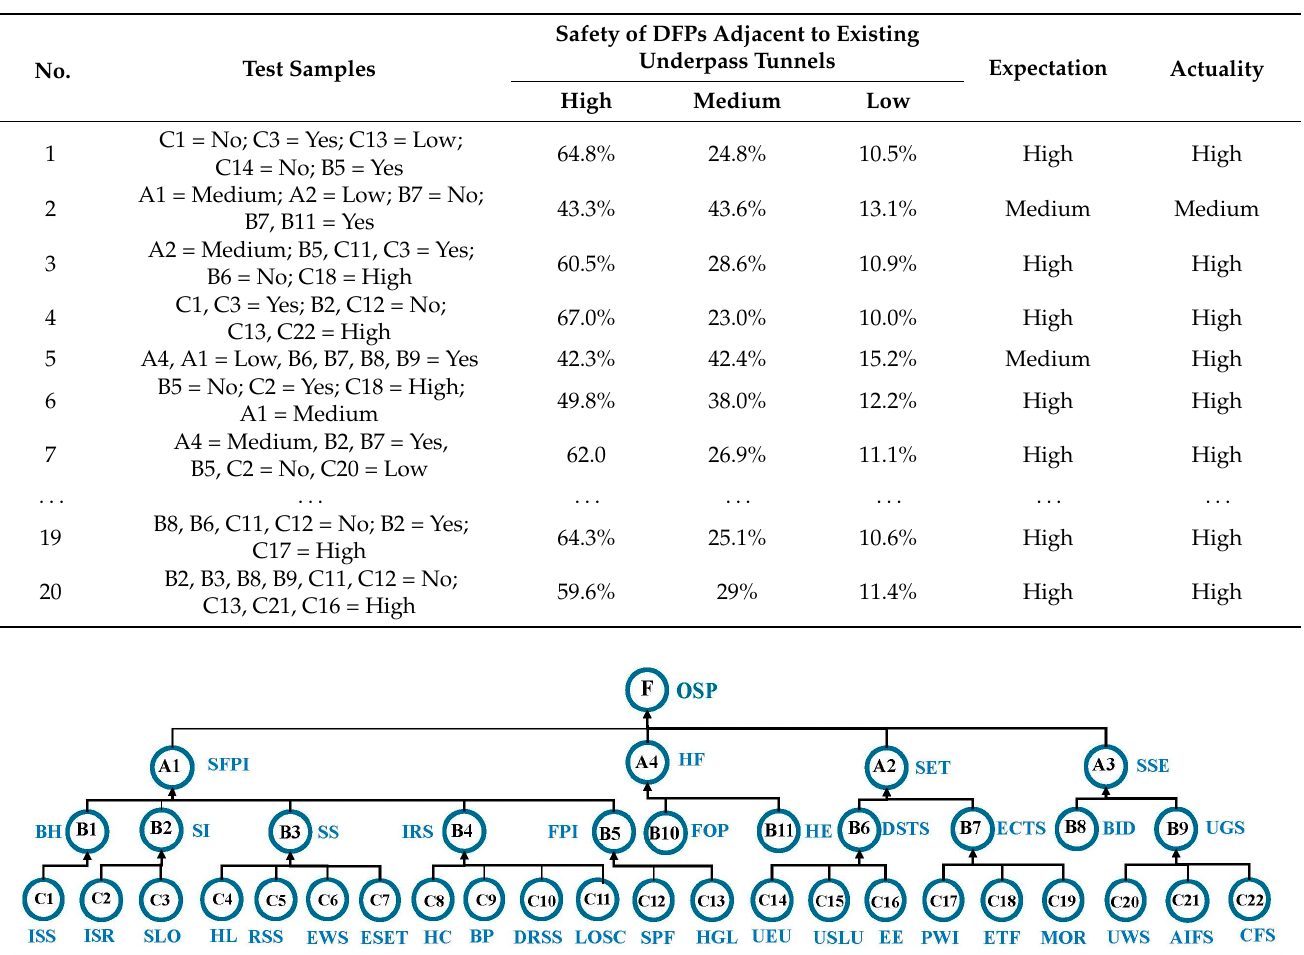
Table 8. Model validation (comparison of predicted and actual results).